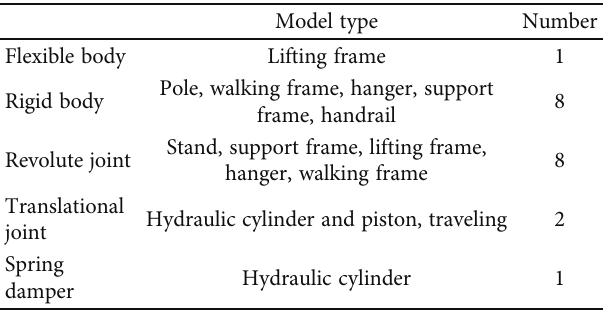
Table 2: Main parameters of the patient transfer device. Standing Handrail Bracket